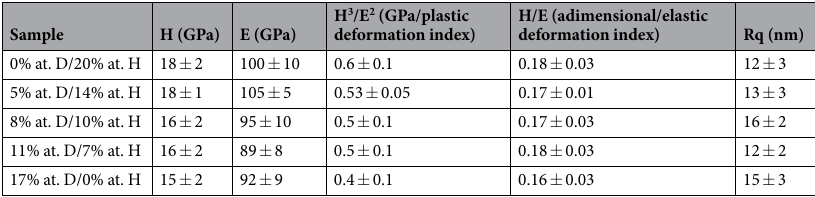
Table 1. Hardness (H), elastic modulus (E), plastic deformation index (H 3 /E 2 ), elastic deformation index (H/E), and surface roughness (Rq) measured for the a-C:D/H thin